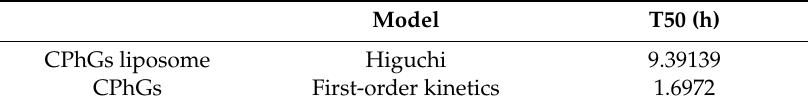
Table 2. The dissolution parameters of CPhGs liposome and CPhGs.